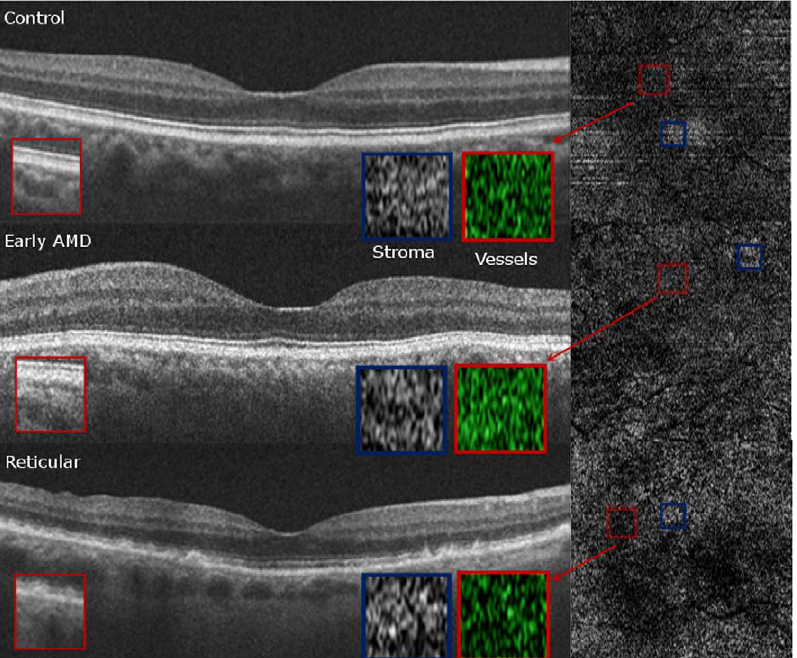
Figure 5. Qualitative Choriocapillaris Assessment Comparing C-Scans and B-Scans (Example 1). When comparing control (top panel), early age-related macular degeneration (AMD, middle panel) and reticular (bottom panel) patients, the appearance of representative C-scans obtained just below the retinal pigment epithelium in reticular groups (bottom right) was qualitatively different from the choriocapillaris scans obtained in the control and AMD groups (top right and center right, respectively). Red boxes on the B-Scans (left) show magnified and colorized selected areas of choroidal vasculature from the regions contained by the smaller red boxes on the C-Scans (right) for each group. Blue boxes on the B-Scans (left) show magnified areas of selected stroma from the regions contained by the smaller blue boxes on the C-Scans (right). Stromal sections demonstrate more patchy whitish regions in the RPD group (bottom panel) as compared to the control and AMD groups (top and middle panels) but similar vessel density due to the presence of larger